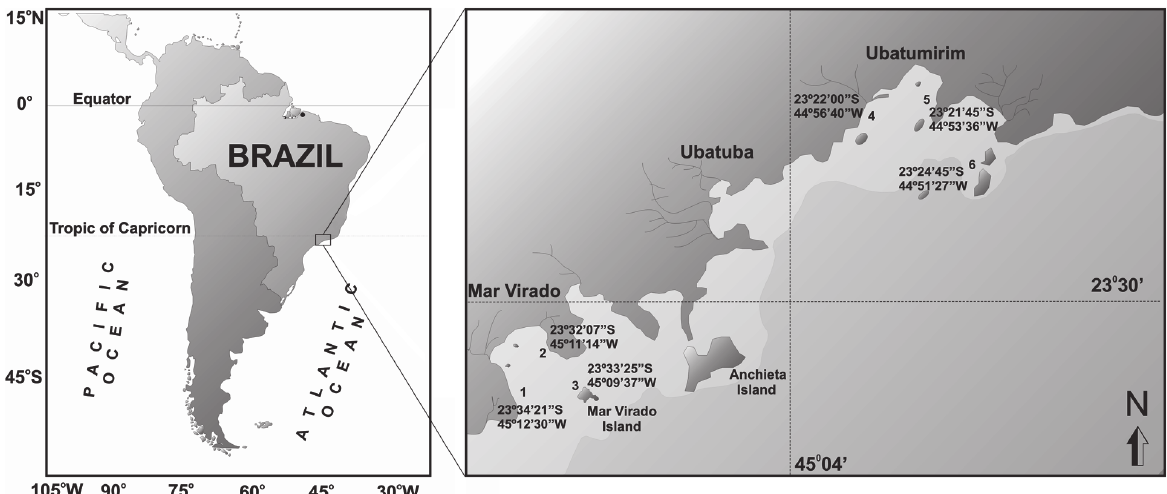
Fig. 1 - Ubatuba region, indicating the sampling